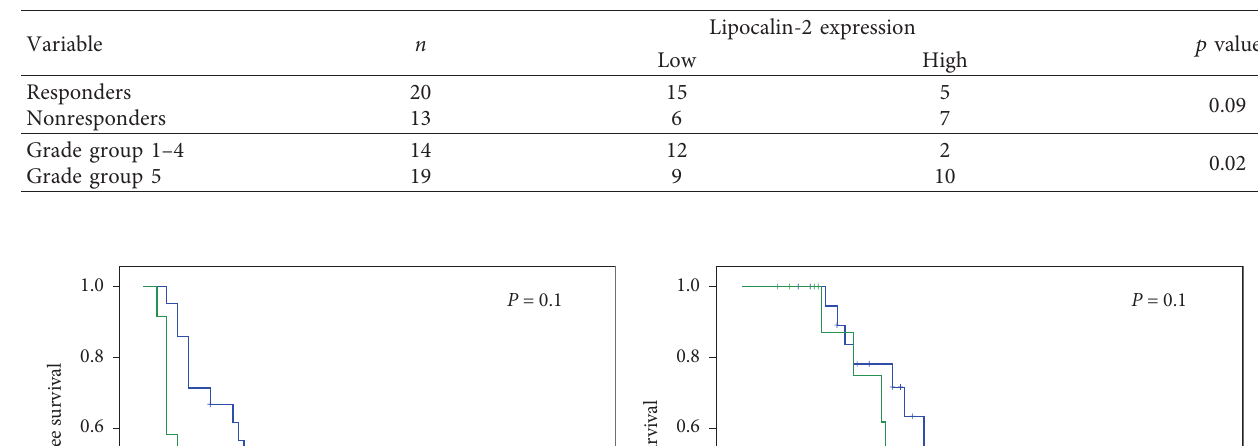
Table 1: Associations between the clinicopathological variables and lipocalin-2 expression.